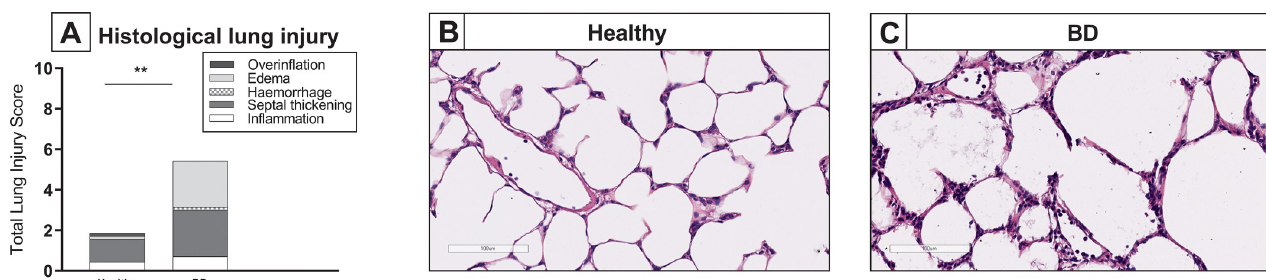
Fig 5. Lung morphology after lung procurement. Lungs were procured from either healthy rats (experimental group 1) or rats subjected to 3 hours of brain death (BD, experimental group 2). Histological lung injury was scored after staining for hematoxylin and eosin (H&E). (A) Quantification of lung injury scores in H&E-stained lung slides. (B-C) Representative H&E-stained slices of healthy donor lungs and lungs from brain-dead donors. �� p < 0.01 in healthy donor lungs versus lungs from brain-dead donors.